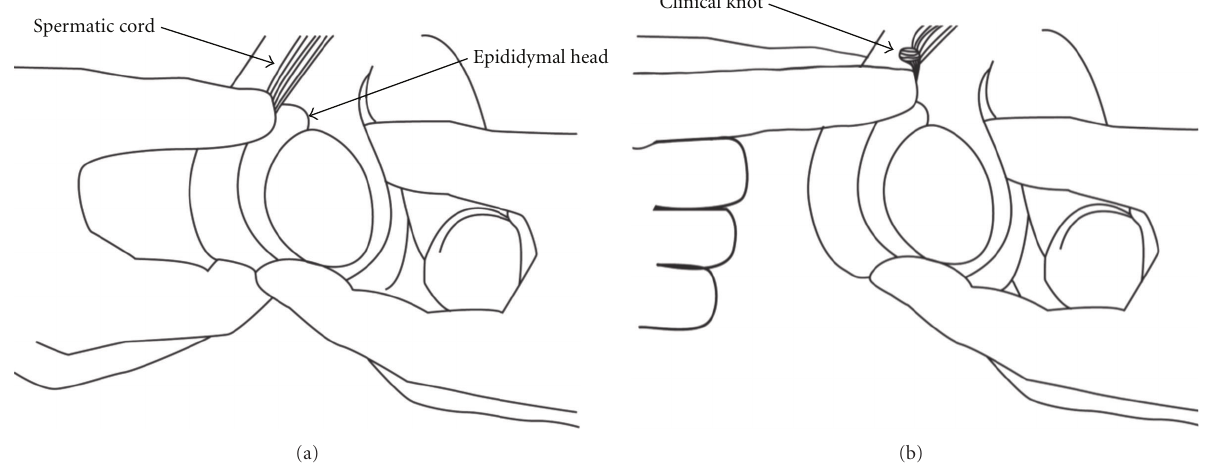
Figure 1: (a) Bimanual examination demonstrating normal findings. (b) Palpation at the junction of the spermatic cord and epididymal head whereby the clinical knot can be felt.